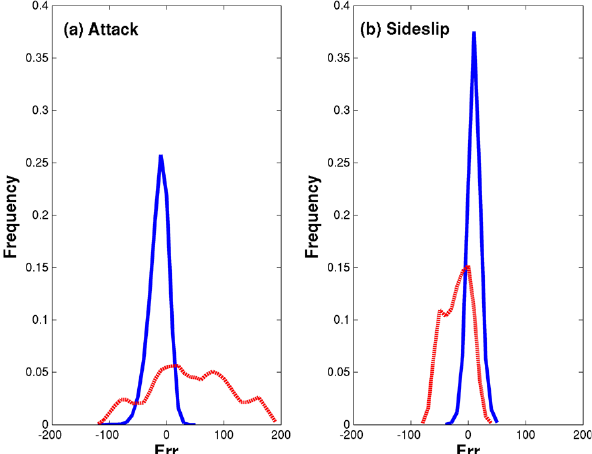
Fig. 12. Distribution of errors [Pa] for data shown in Fig. 11 before correction (red) and residual after correction (blue) for (a) attack angle changes; and (b) sideslip angle